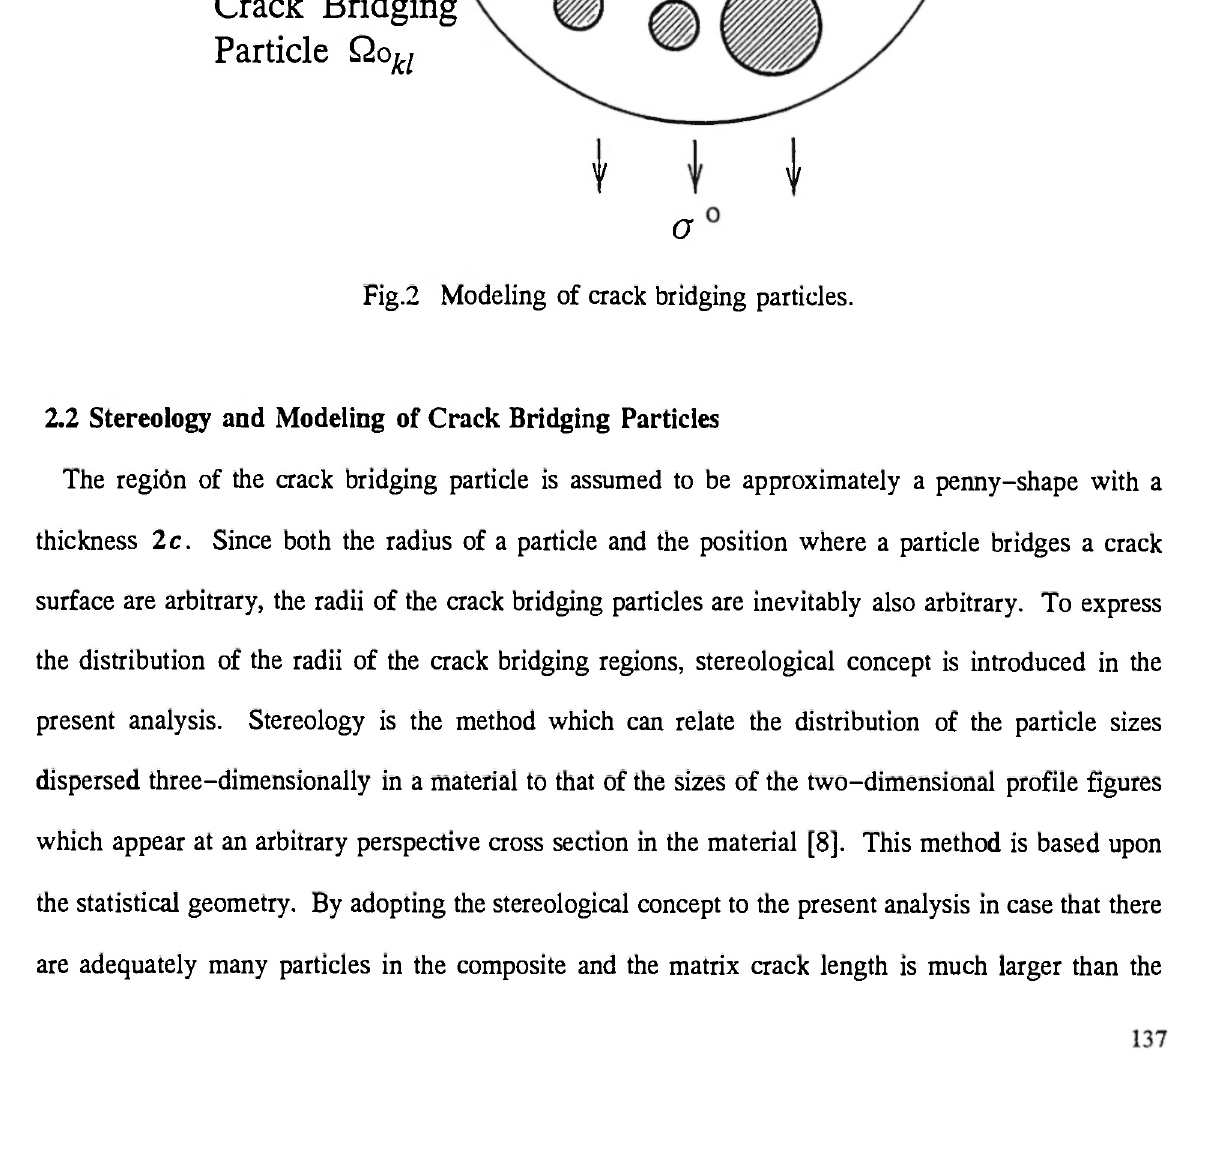
Fig.2 Modeling of crack bridging